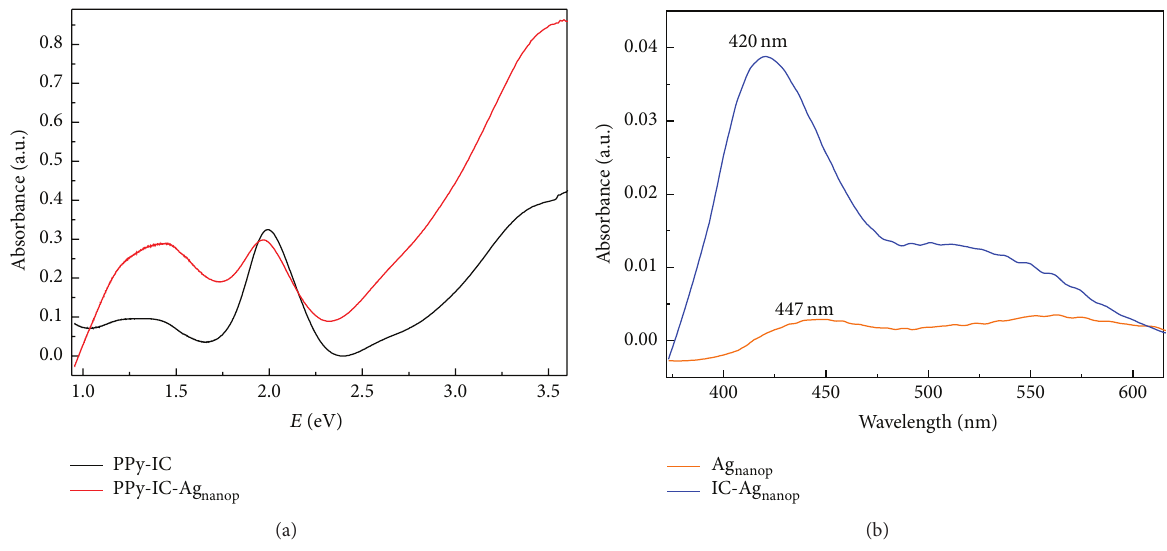
Figure 3: UV-VIS-NIR absorption spectra of (a) PPy-IC and PPy-IC-Ag nanop films and (b) Ag nanop and IC-Ag nanop